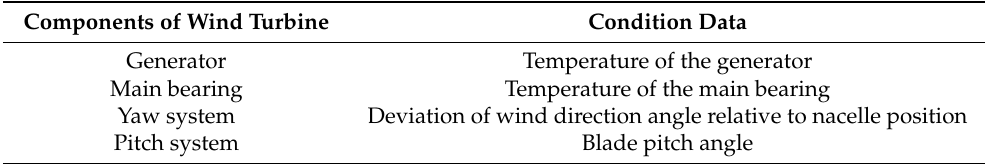
Table 1. The SCADA data selected as the condition data of the